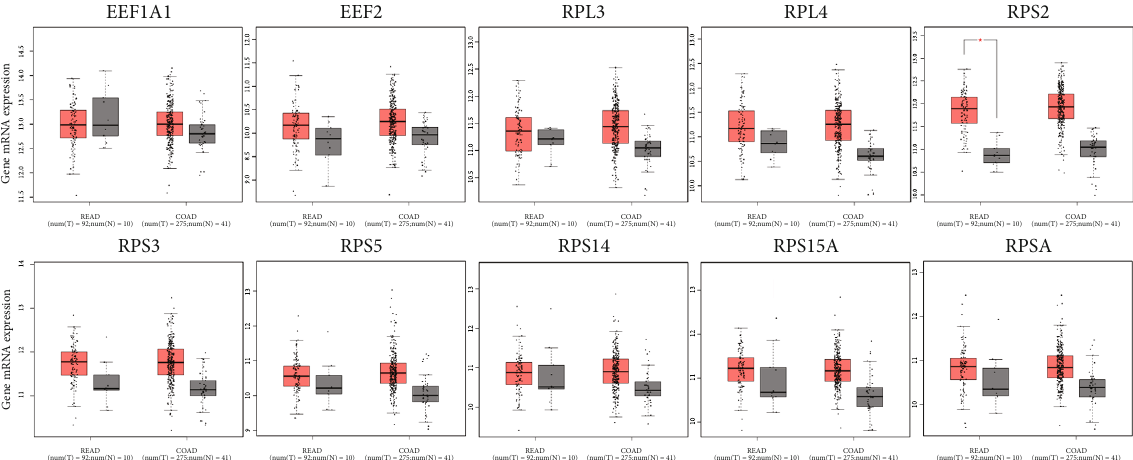
Figure 5: The mRNA expression of hub genes between tumor and normal using the GEPIA platform. Boxplot was used for mRNA expression between tumor (red) and normal (grey). READ: rectal adenocarcinoma; COAD: colon adenocarcinoma.